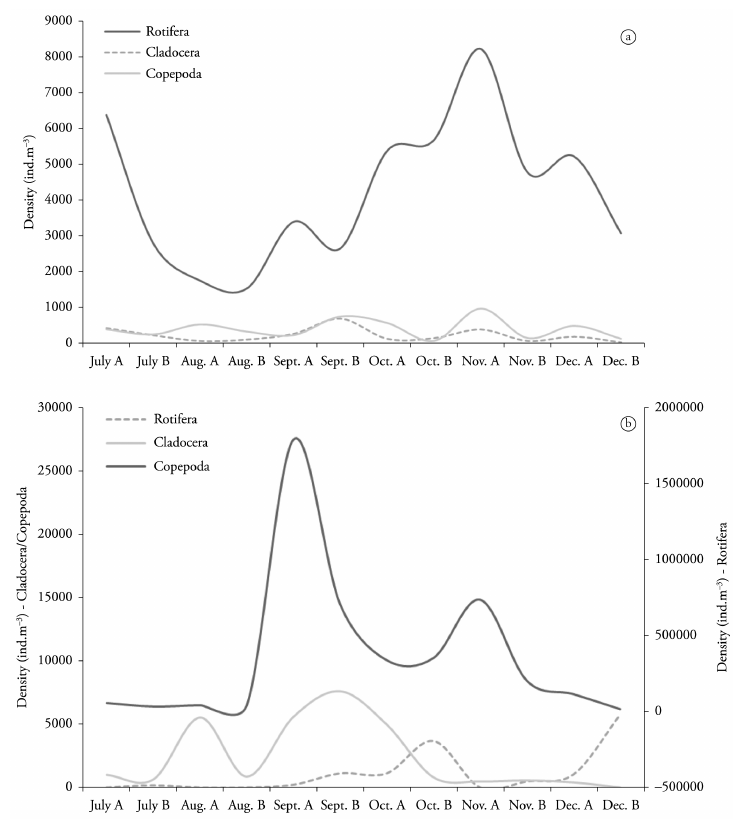
Figure 4. Population fluctuation of zooplankton groups (ind.m -3 ) from Lake I (a) and Lake II (b) in Clube Caça e Pesca Itororó de Uberlândia, Minas Gerais